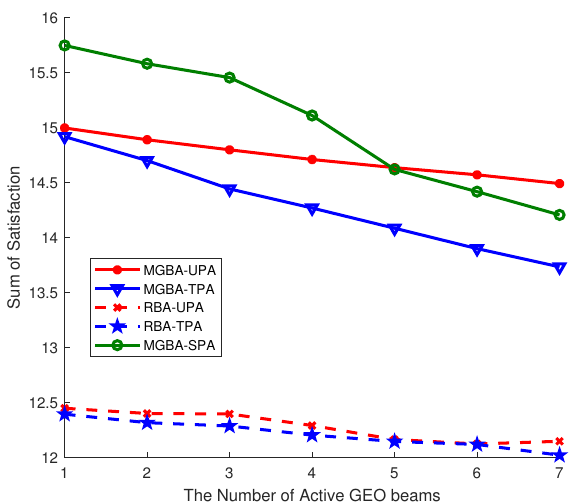
Figure 4. The sum of satisfaction performance comparison against different numbers of active GEO beams G